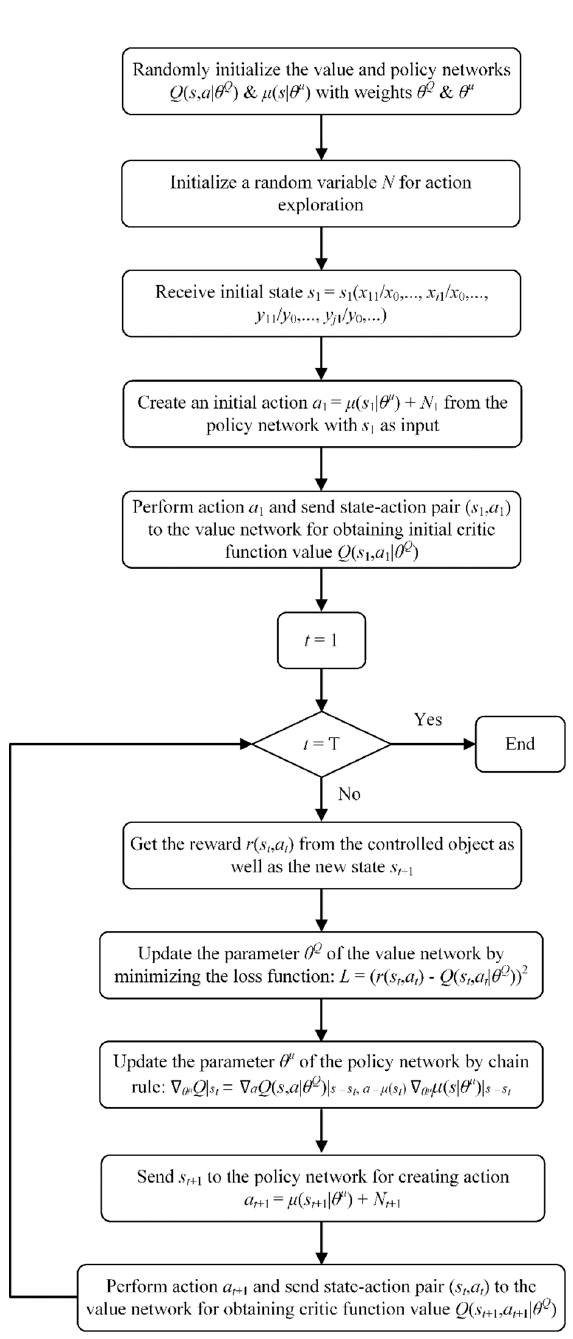
Figure 3. Flowchart of on-line reinforcement learning method based on multi-physical field sensing.